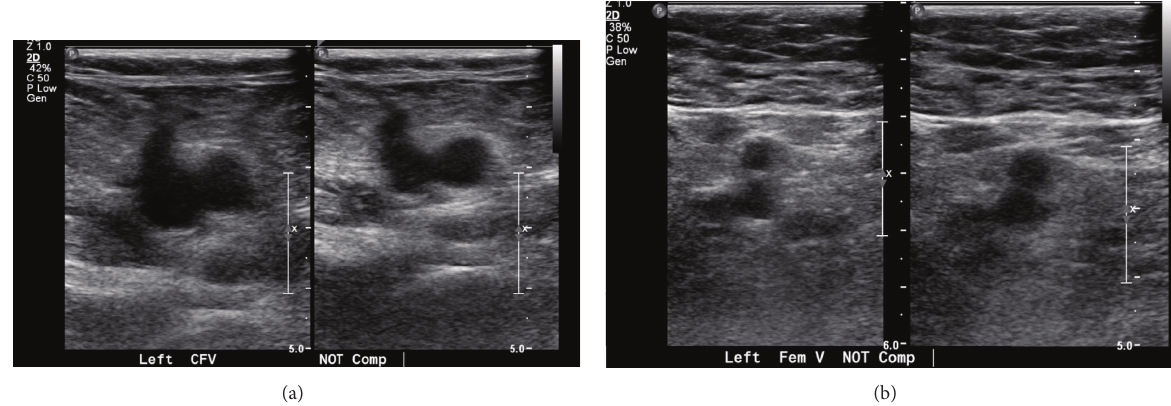
Figure 1: Doppler US of left lower limb showing DVT in the left common femoral (a) and femoral veins (b).